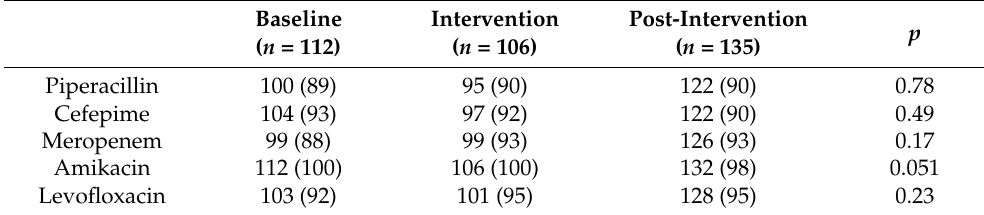
Table 6. Susceptibility of Pseudomonas aeruginosa to each antibiotic, n